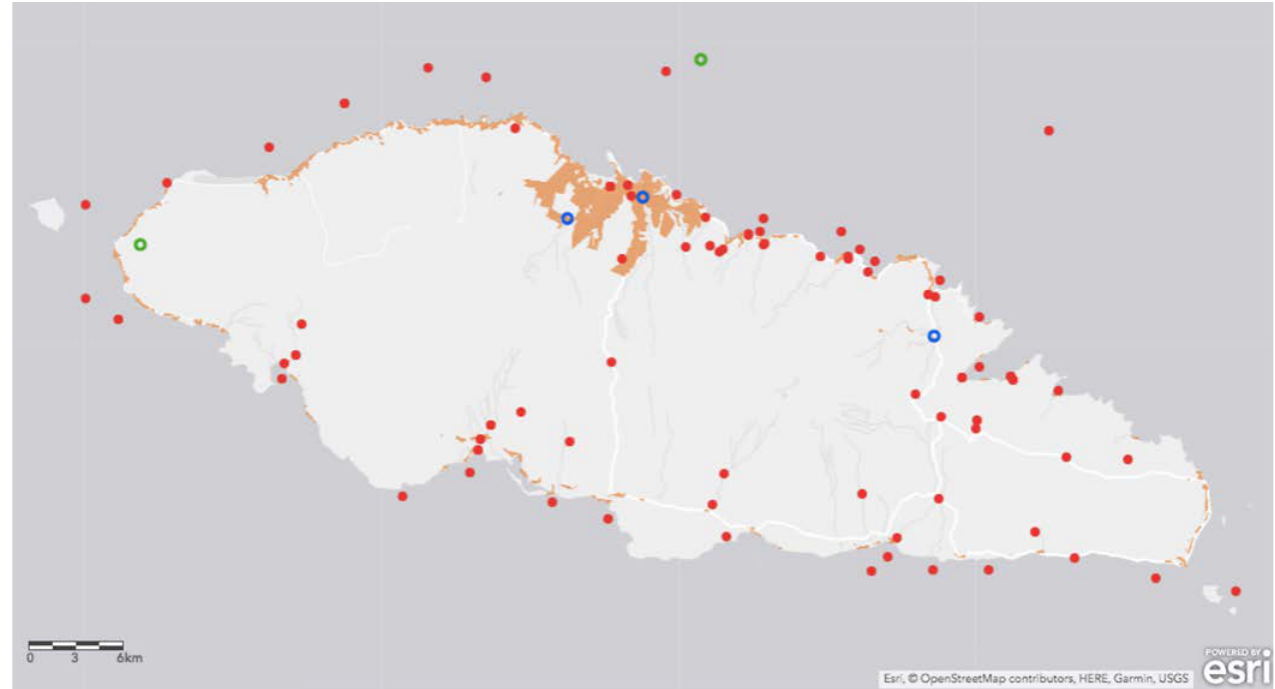
Figure 1. Map of Upolu Island waterways, the distribution of coliform bacteria as tested by Colilert Test Kit. Colored symbols represent sample sites: no coliform bacteria detected (green rings), coliform detected (blue rings) and coliform and >1 cell/100 mL fecal E. coli detected (red